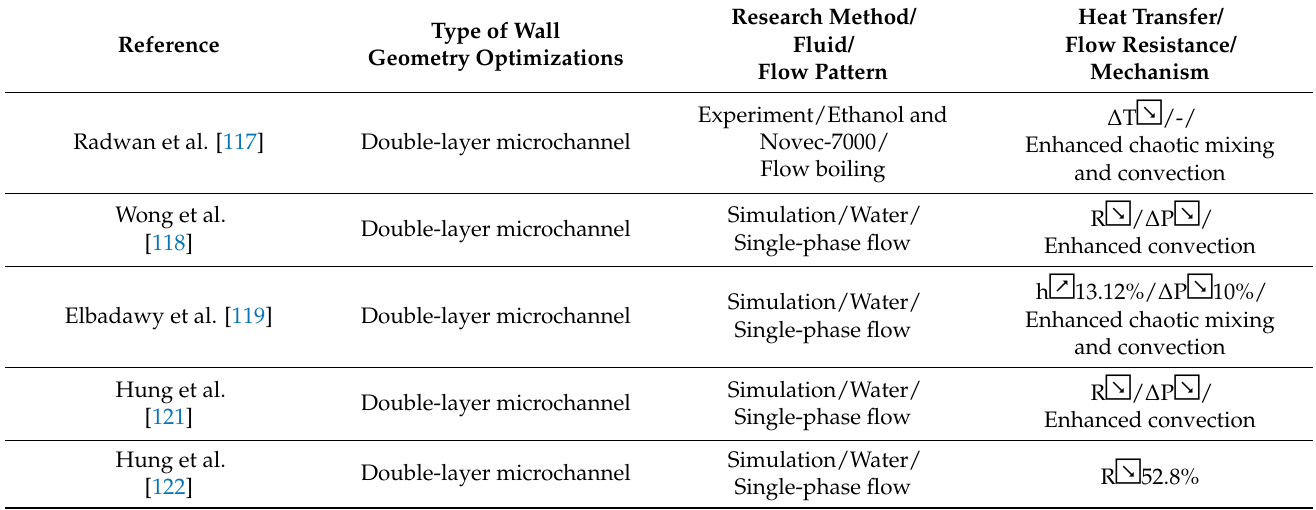
Table 3. Selected studies of geometric optimization on sidewall and bottom wall of the microchan- nel on heat transfer.